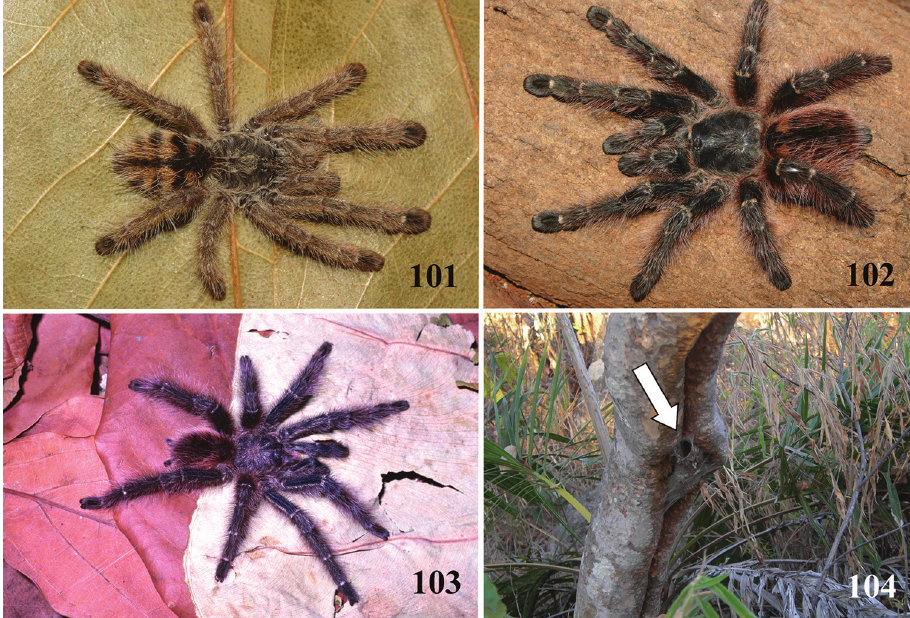
Figures 101–104. Avicularia taunayi (Mello-Leitão, 1920), habitus and retreat. 101 immature 102 female 103 male 104 retreat inside trunk of Myrcia tormentosa (Aubl.). Arrow indicating retreat opening. Photos: 101–103 R. Bertani; 104 C. S.